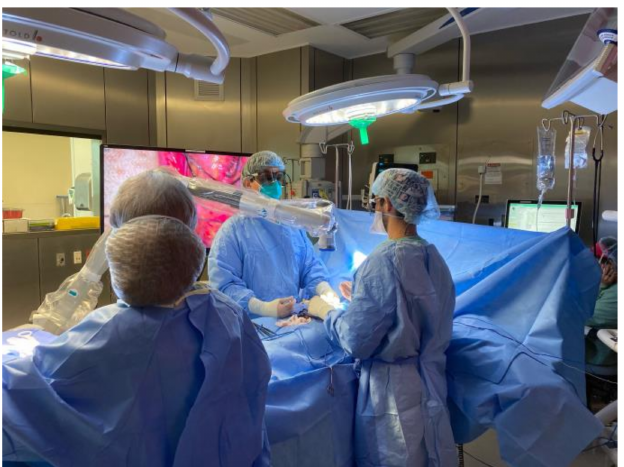
Figure 1. Olympus 4K3D Orbeye video microscope being utilized for male infertility microsurgery. Both surgeons are able to view large, high-definition screens with a less bulky microscope. (Reprinted with permission from